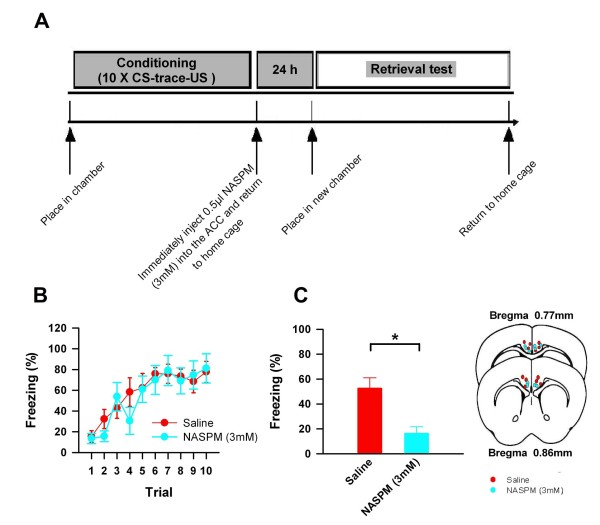
ACC CP-AMPA receptors are necessary for trace fear memory. (A) Immediately following trace fear conditioning, we exposed mice to bi-lateral, intra-ACC microinjections of either NASPM (3 mM, 0.5 μl/side) or saline (0.5 μl/side). (B) Learning curves. (C) (Left) When tested in a new environment 24 h later, mice exposed to intra-ACC injections of NASPM displayed significantly less freezing behavior in response to the CS (saline: n = 6; trace: n = 5, t = 2.51). (Right) Representative markers indicating microinjection locations. (* P < 0.02).